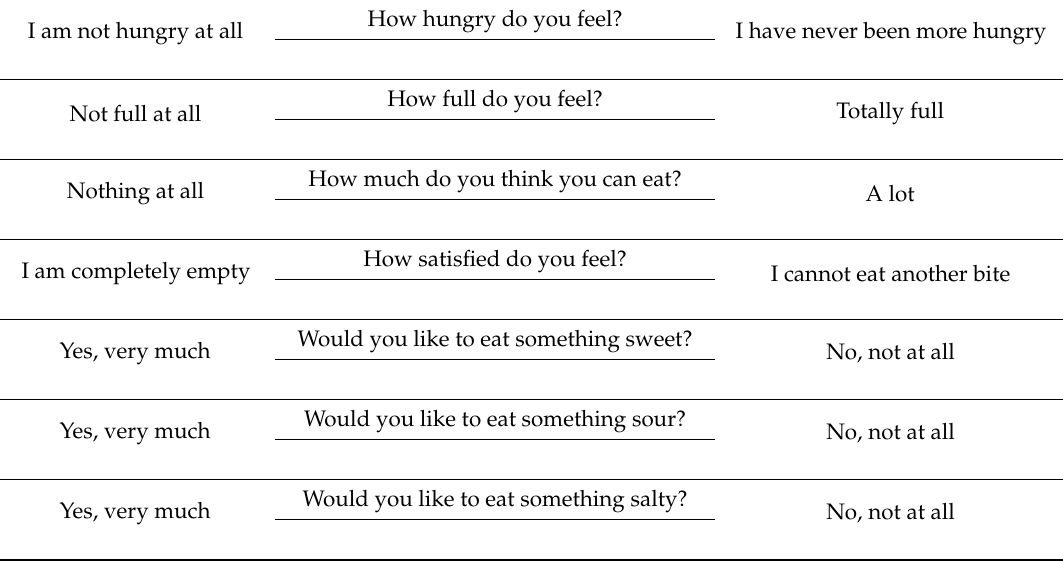
Table A3. Questionnaire with ratings of appetite, satisfaction and desire for specific tastes (English